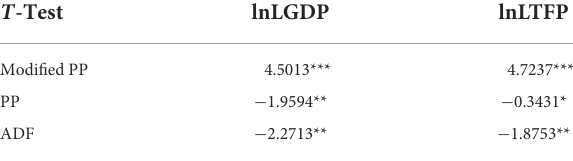
TABLE 4 Co-integration test